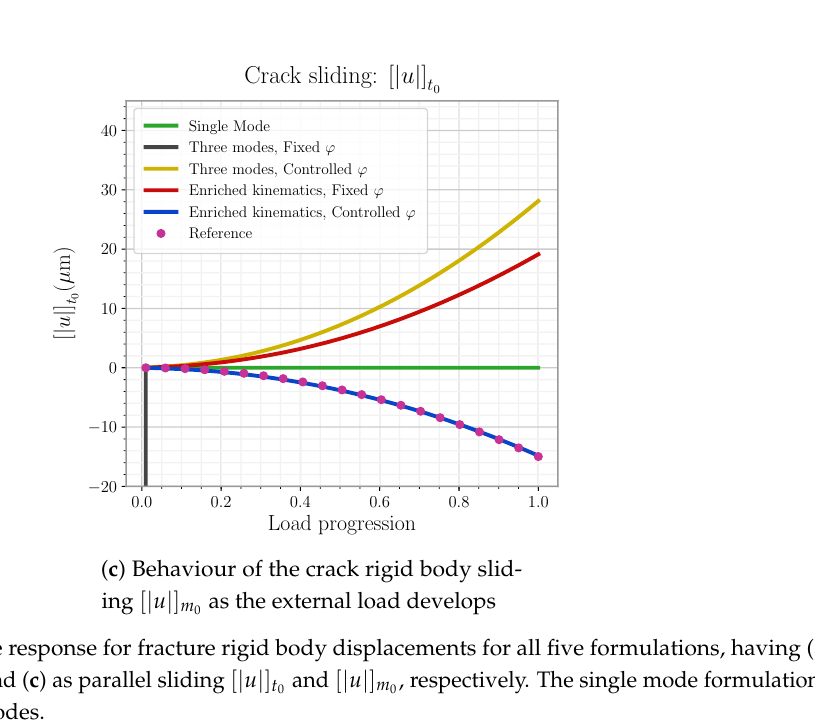
] t ] m u u and [ , respectively. The single mode formulation has been 0 0 | | | |